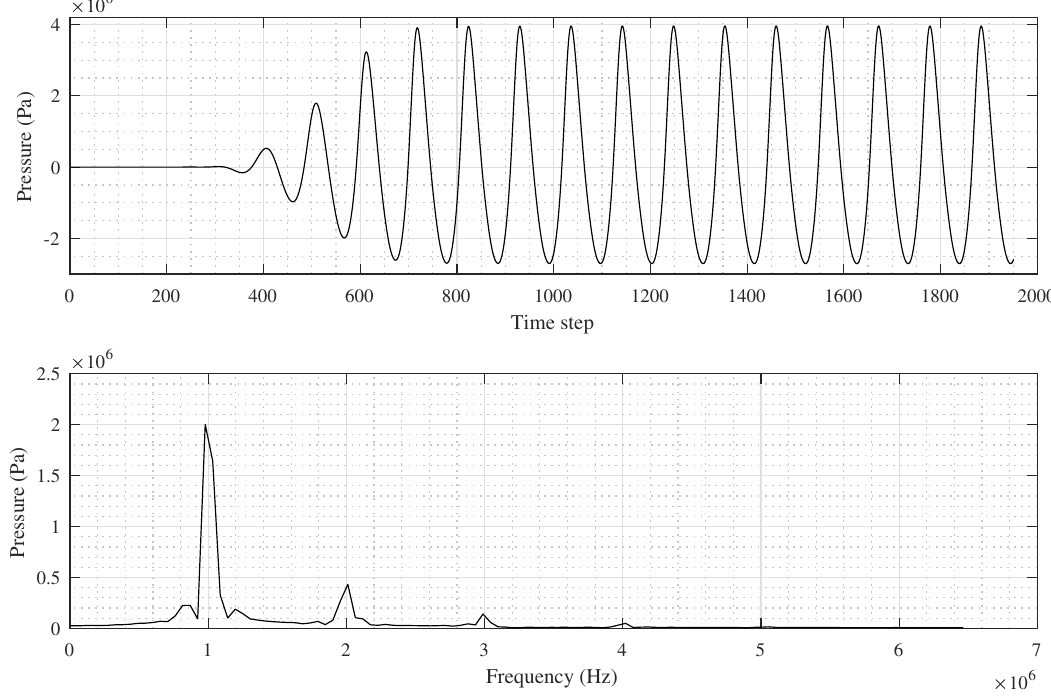
Figure 1. The illustration of a high-intensity focused ultrasound (HIFU) simulation signal at one point in 3D